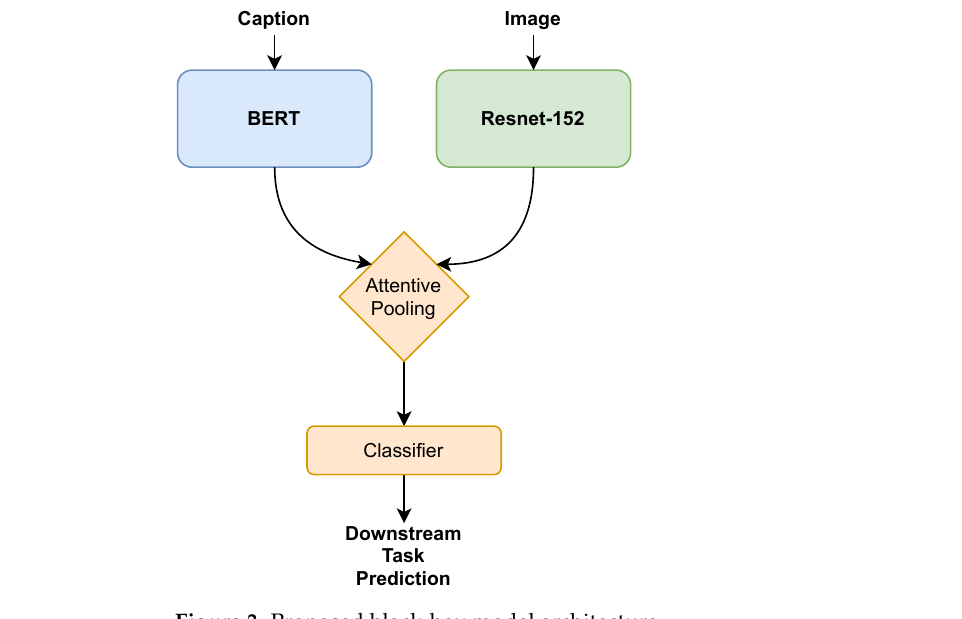
Figure 3. Proposed black-box model